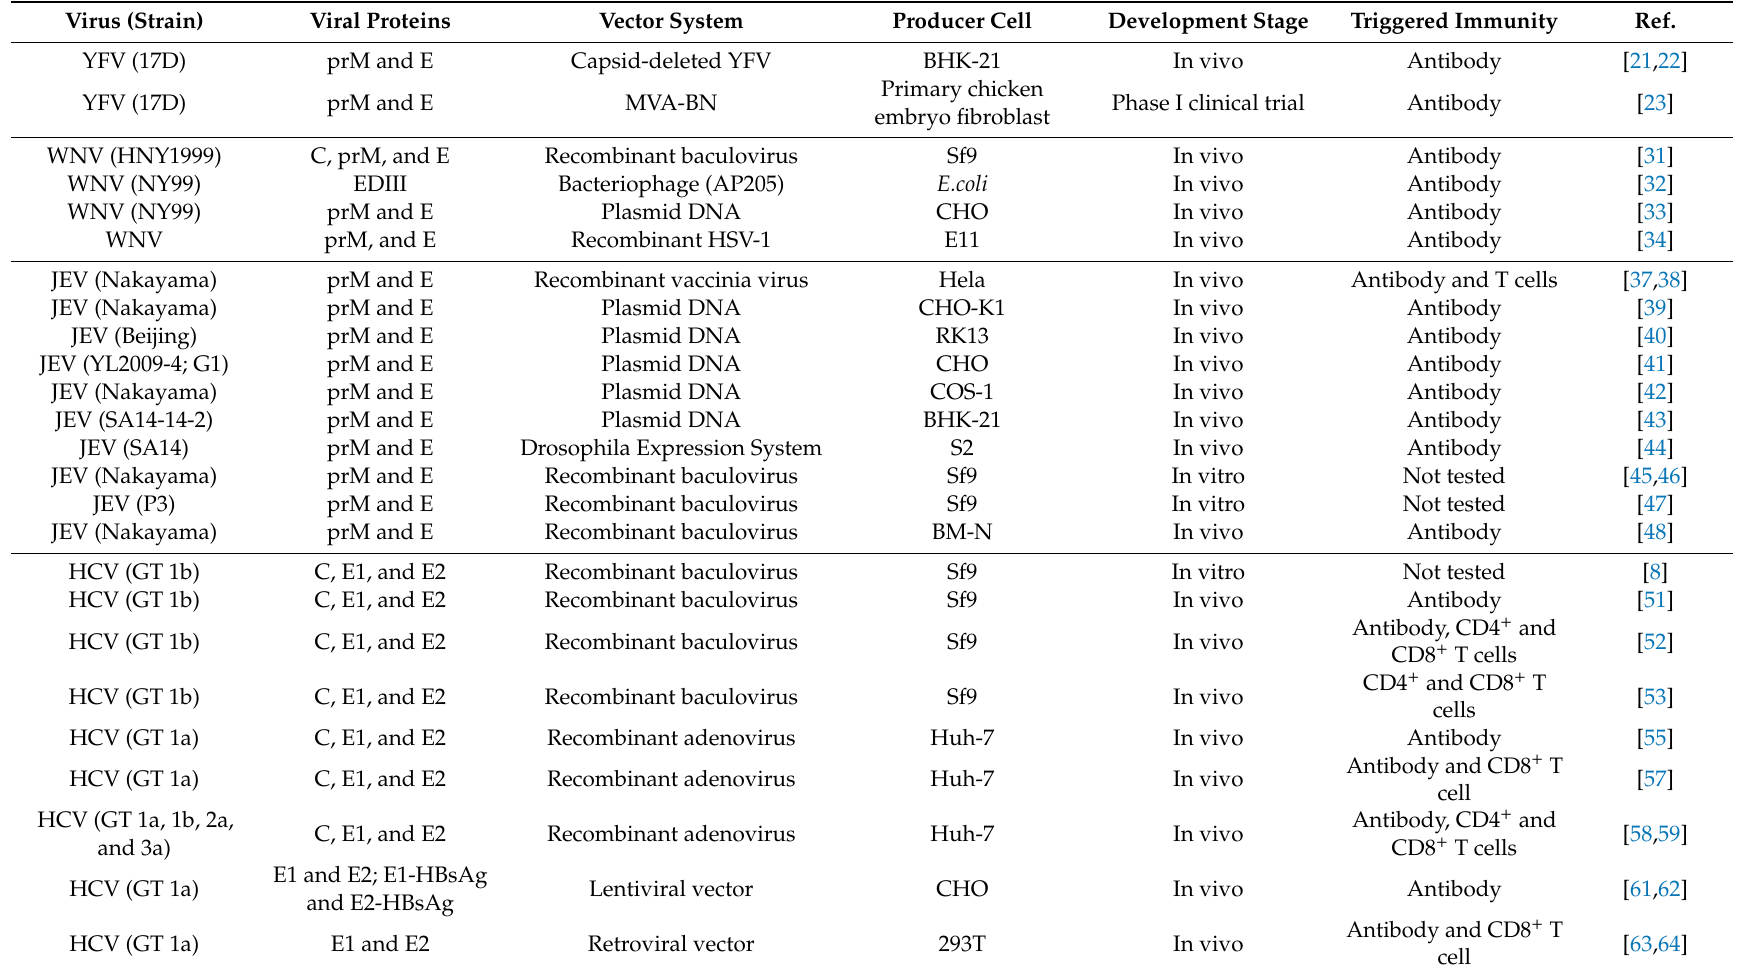
Table 1. Summary of flavivirus-like particles for vaccine